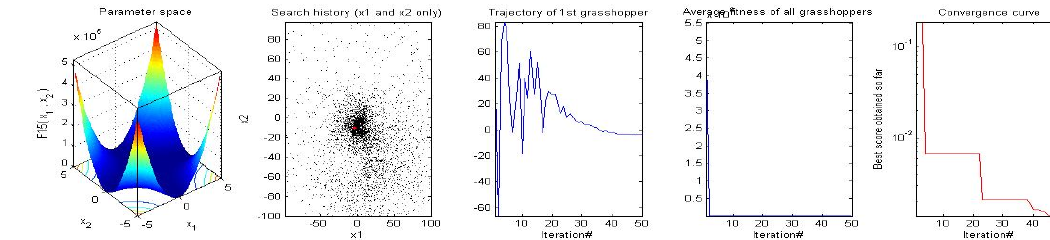
Figure 16. HAGOA behavior on multimodal function (F15)